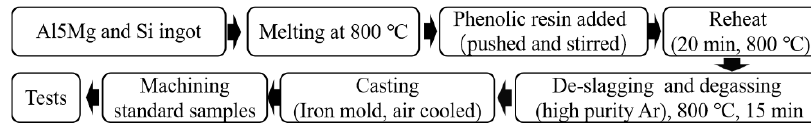
Figure 1. The schedule of 3C – SiC/MgAl 2 O 4 /MgO/Al – Mg – Si fabricated process. The resin was added as the carbon and oxygen source in the range of 0.3, 0.9, 1.5, and 2.1%, whilst the contents of the matrix alloy listed in Table 1. Bal. is the balance of contents. Table 1. The contents of the matrix alloy (%).